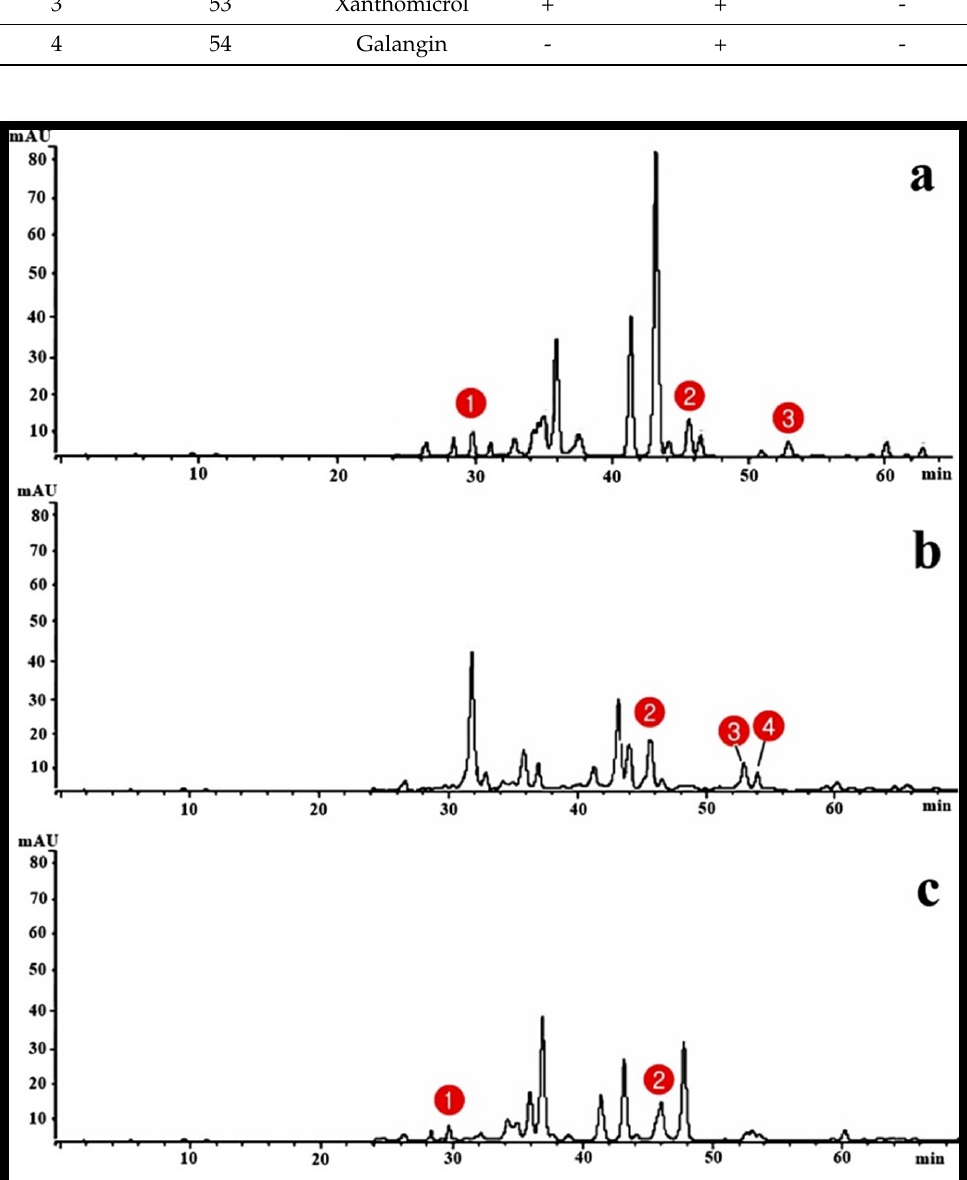
Figure 3. The HPLC chromatogram for the honeybee propolis methanolic extract from the two locations in Saudi Arabia: ( a ) Al Hada, ( b ) Rawdat Khuraim, ( c ) Baljurashi; the red spots indicate the peak numbers of compounds 1. Pinobanksin, 2. Pinocembrin, 3. Xanthomicrol, and 4. Galangin.